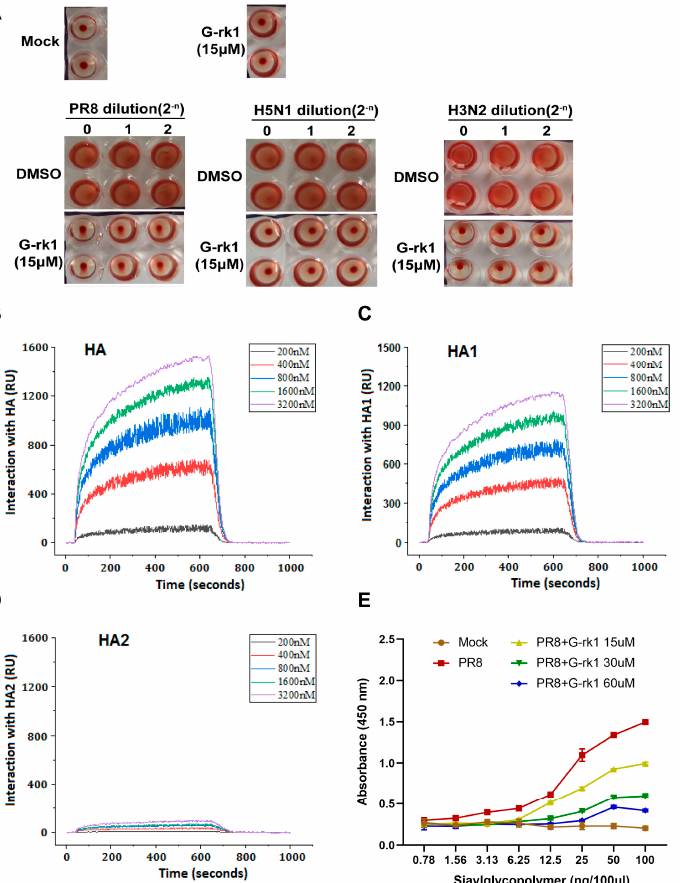
Figure 4. Identifying HA as the potential target of G-rk1. In ( A ), an HAI assay using 2-fold serially diluted A/Puerto Rico/8/34 (PR8, H1N1), A/Duck/Guangdong/212/2004 (H5N1), and A/Guangdong/Dongguan/1100/2006 (H3N2) viruses (staring at 16 HA units) and 1% CRBCs was performed in the absence or presence of G-rk1. In ( B – D ), HA or HA1 or HA2 from PR8 virus was immobilized on a photo-cross-linker sensor chip. Subsequently, G-rk1 was injected as an analyte at various concentrations, and PBST was used as the running buffer. The interaction signals were retrieved and analyzed with bScreen LB 991 software. The affinities of the interactions between G-rk1 with HA, HA1, and HA2 are shown in ( B – D ), respectively. In ( E ), PR8 virus (64 HA units) was treated with or without G-rkl for 2 h at 37 ◦ C and then added into the plate coated with Neu5Ac α 2- 3Gal β 1-4GlcNAc β -PAA-biotin (3 (cid:48) -SLN) at 4 ◦ C for 12 h. The plate was then incubated with mouse monoclonal antibody against HA protein of H1 subtype at 4 ◦ C for 3 h, and then washed with PBST and incubated with HPR-labeled goat anti-mouse IgG for 2 h at 4 ◦ C. The absorbance values were read at 450